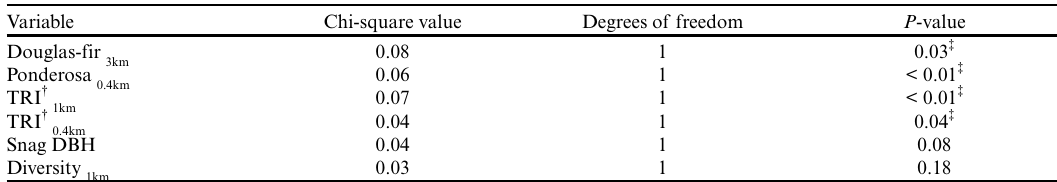
Table 3 . Summary of Monte-Carlo tests conducted on the canonical correspondence analysis for the ordination of cavity-nesting woodpeckers and owls and the habitat characteristics with which they associated. Results for predictor variables chosen based on the backward variable selection procedure are shown. Subscripts indicate the extent at which each variable was selected. Douglas-fir ( Pseudotsuga menziesii ), ponderosa pine ( Pinus ponderosa ).